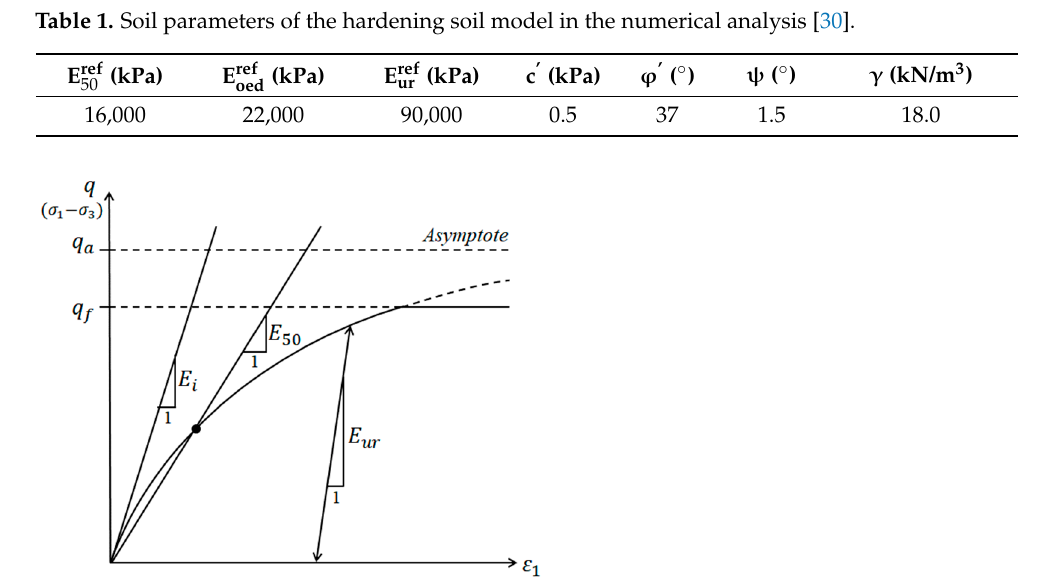
Figure 2. Relationship between stress and strain in the hardening soil model [39].